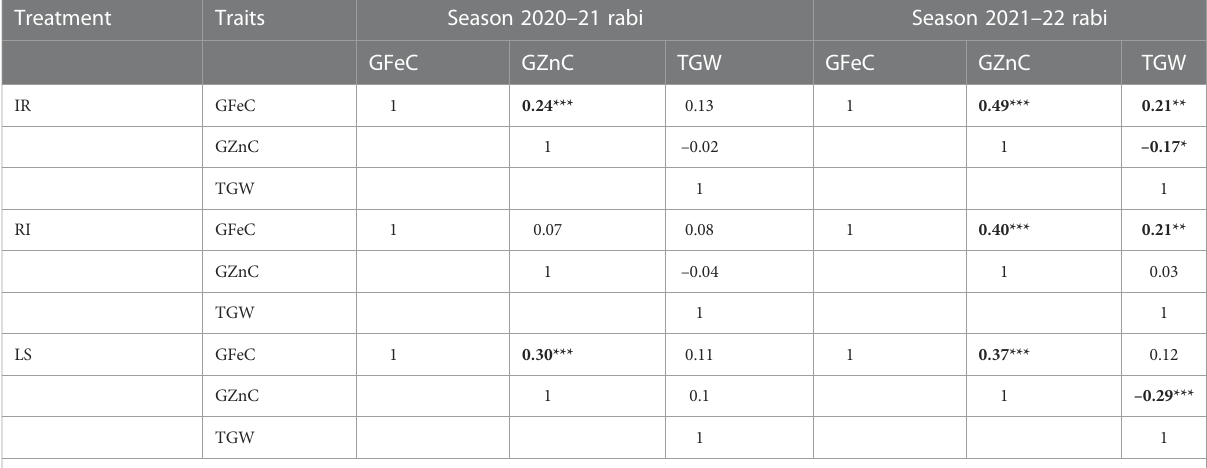
TABLE 2 Correlation among the traits of grain iron content (GFeC), grain zinc content (GZnC), and 1000-grain weight (TGW) in each environment. Treatment